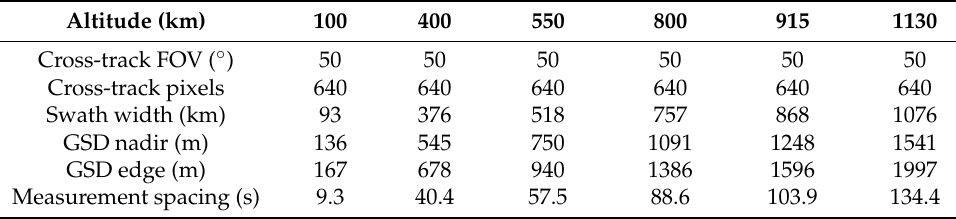
Table 6. Performance parameters for CMIS flown at different orbital altitudes. Altitude